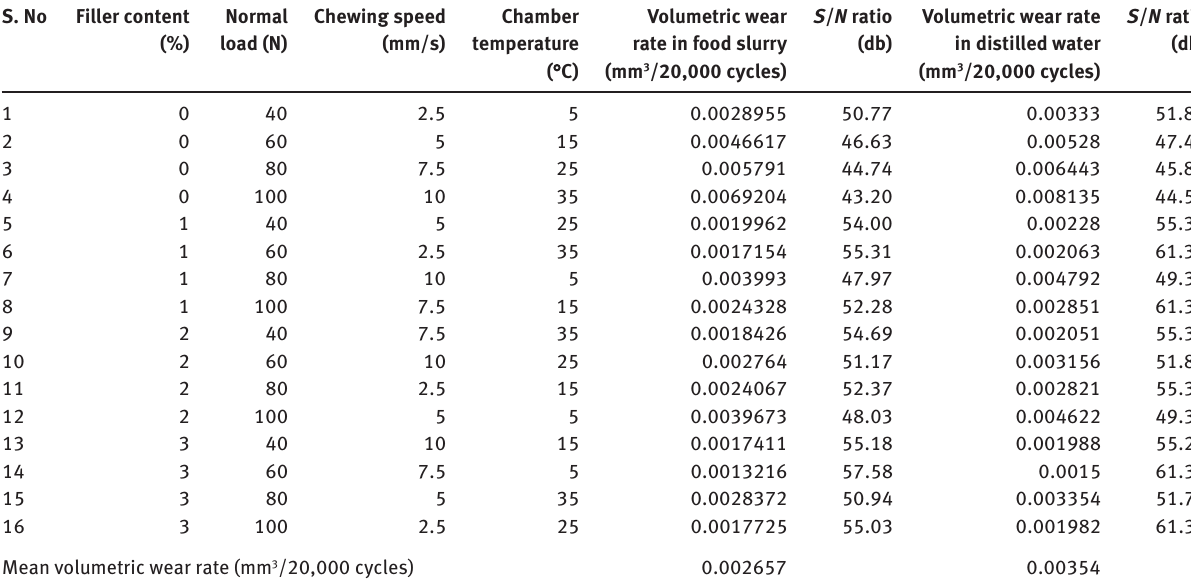
Table 3: Taguchi experimental results for NADC series composite. S. No Filler